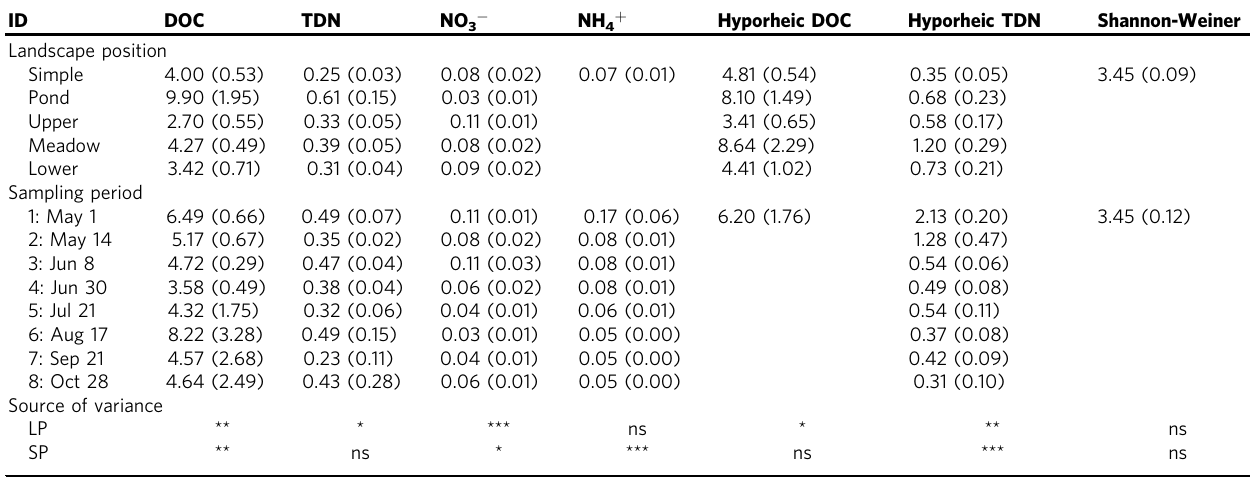
Table 2 Biogeochemical characteristics of surface water and hyporheic sediments ID Hyporheic DOC Hyporheic TDN